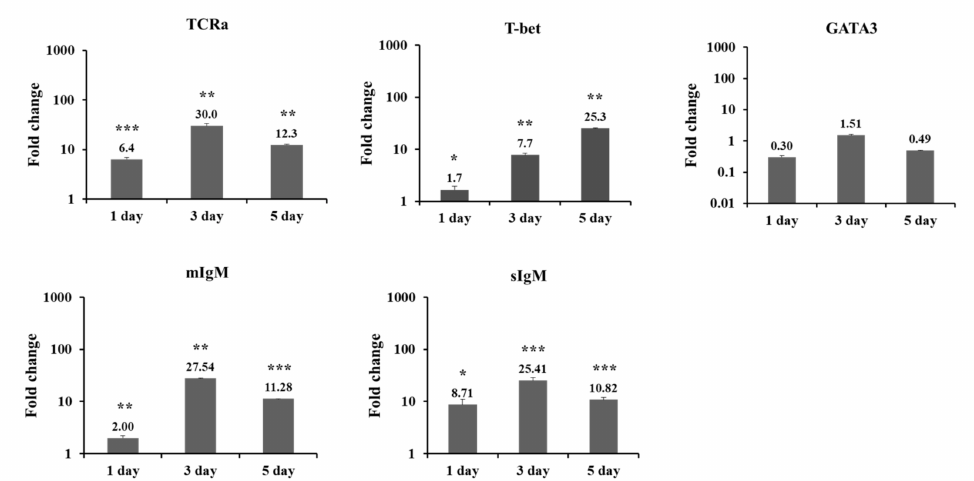
Figure 1. Q-PCR analysis of immune-related gene expression in the head kidney of rainbow trout injected with AV vaccine. Q-PCR data were normalized relative to the expression of the reference gene (EF-1 α ) and fold-change was calculated by dividing the ratio to EF-1 α by control sample at days 1, 3, and 5. Data are presented as medians ± standard deviation (SD) (n = 8). Asterisks (*) indicate significant differences (* = p < 0.05, ** = p < 0.01, *** = p < 0.001) between the PBS and AV vaccine